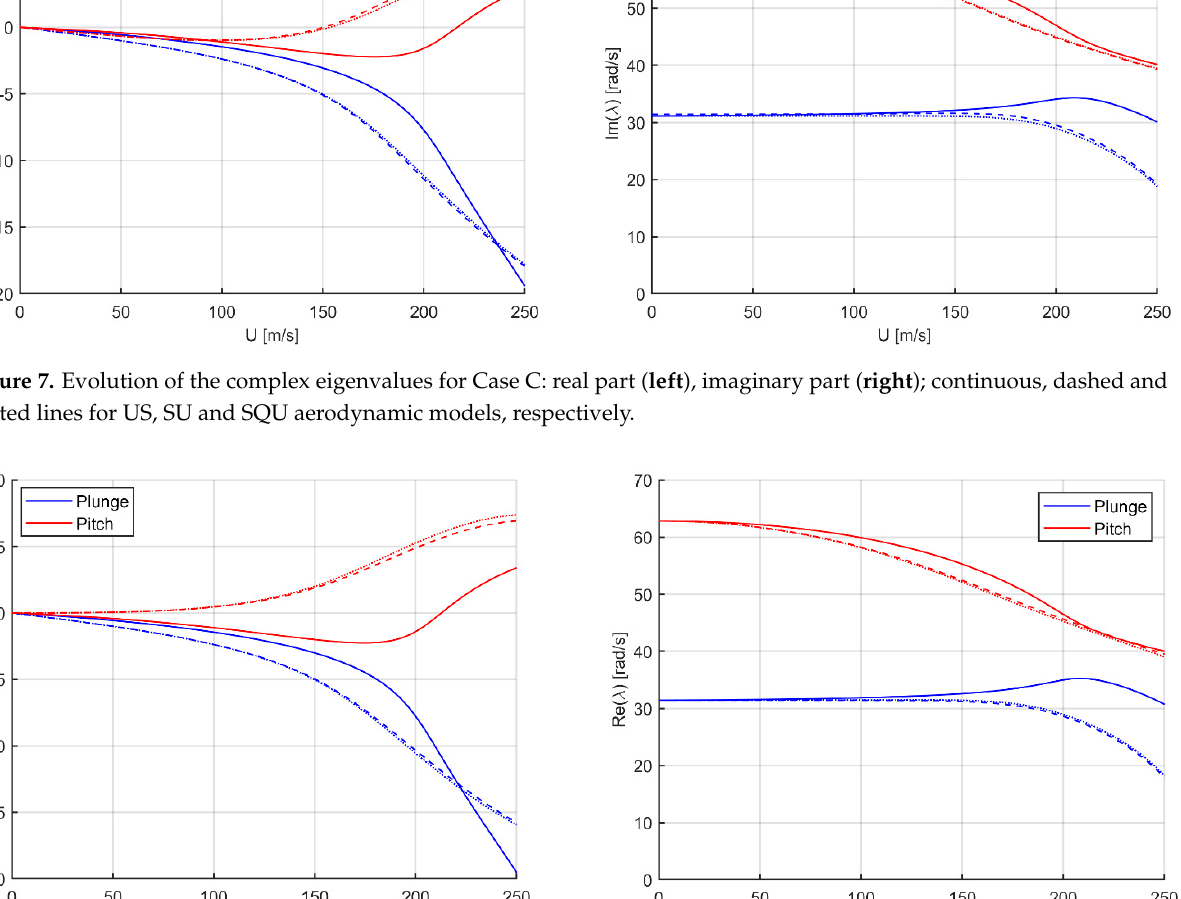
Figure 8. Evolution of the complex eigenvalues for Case C: real part ( left ), imaginary part ( right ); continuous, dashed and